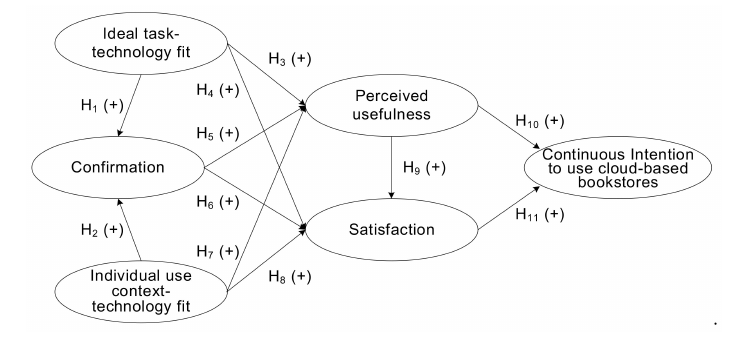
Figure 4. Research model. Table 1. Construct